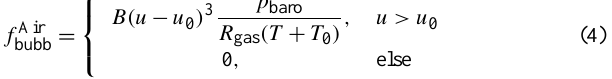
Fig. 2. Information flow between carbon and oxygen variables. Figure 2. Information flow between carbon and oxygen variables. Left: Inverse procedure of run SFC as in Fig. 1, estimating ocean- Left: inverse procedure of run SFC as in Fig. 1, estimating ocean- internal DIC sources/sinks from p CO 2 data. Middle: Prediction of internal DIC sources/sinks from p CO 2 m data. Middle: prediction m